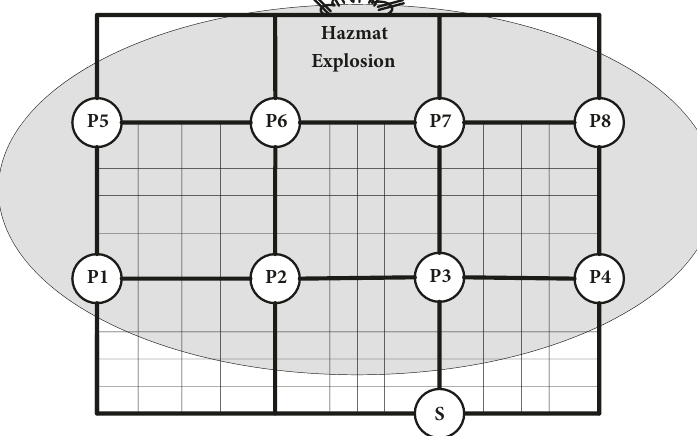
Figure 1: Simplified network for DEU determination in RNBSP